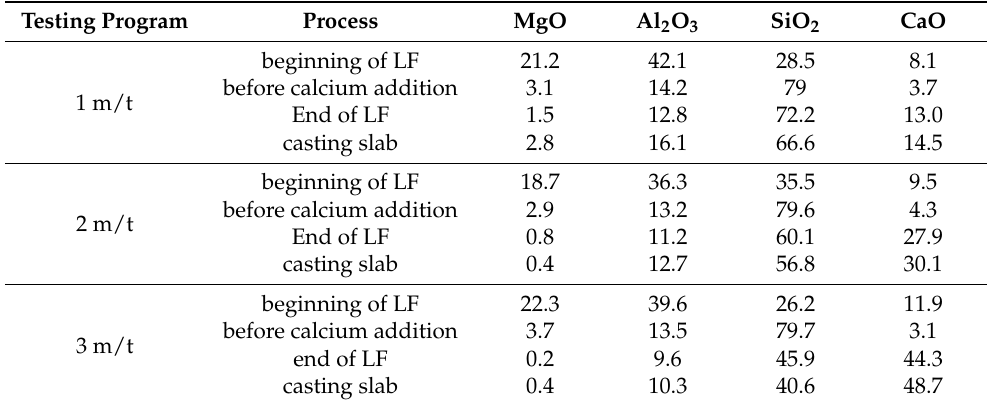
Table 7. Average compositions of inclusions at each stage of tests with different Si-Ca wires addition